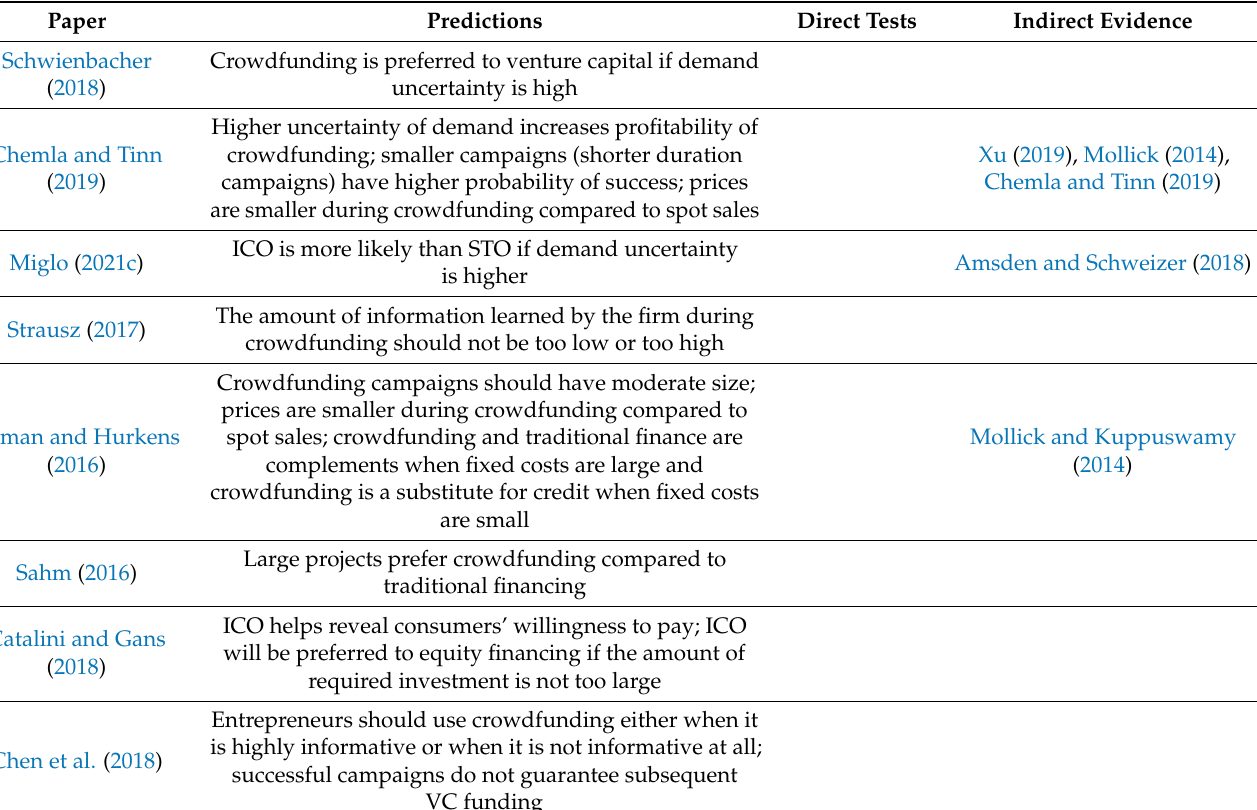
Table 1. Learning-based theories of crowdfunding and token